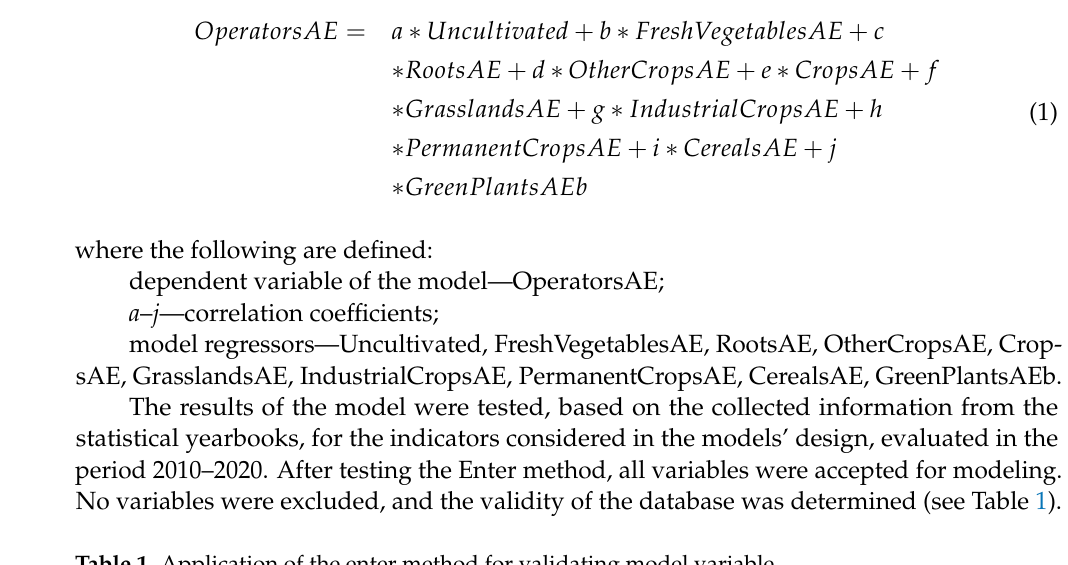
Table 1. Application of the enter method for validating model variable. Variables Entered/Removed a,b Variables Entered Variables Removed Method